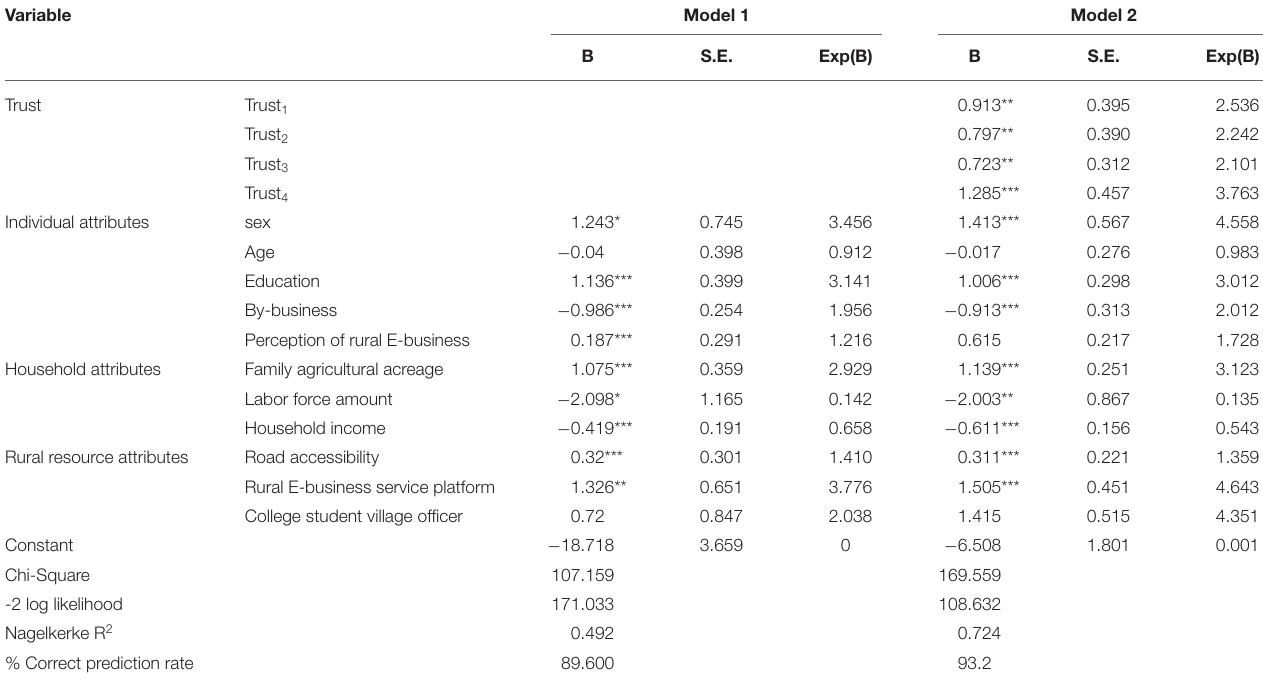
TABLE 4 | The regression results of different models.